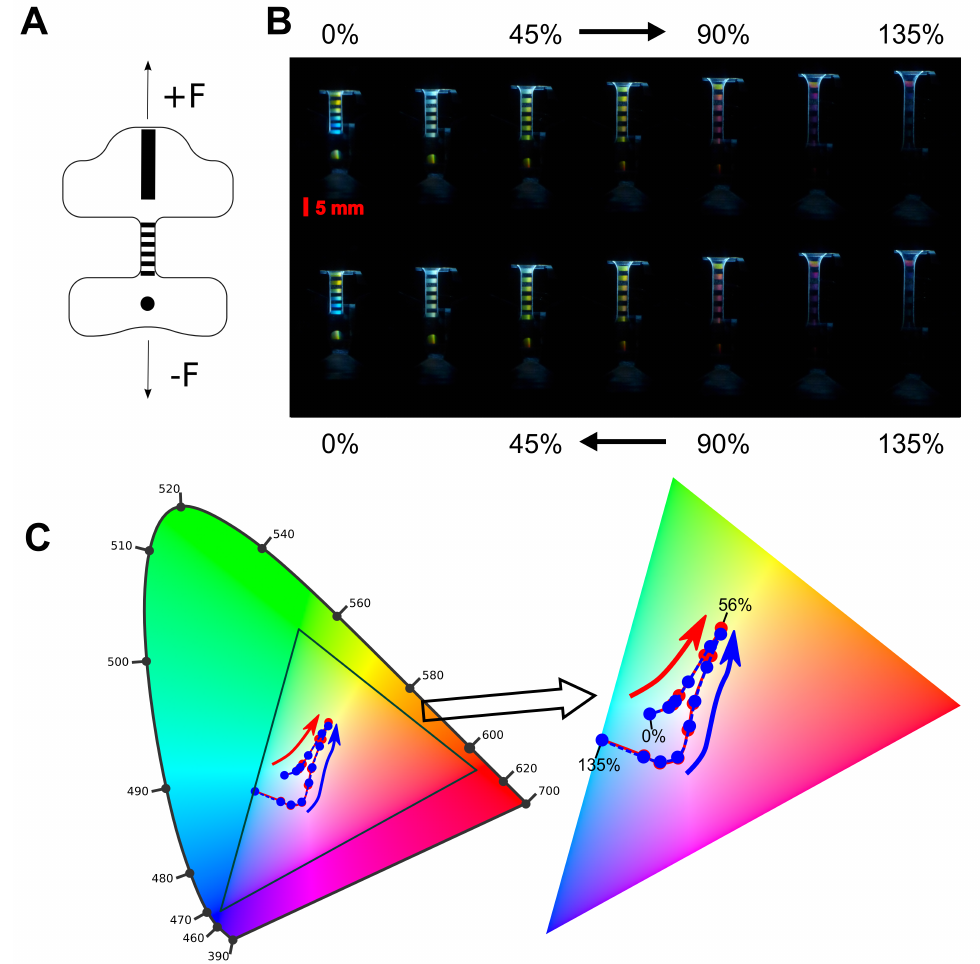
Figure 6. ( A ) Schematic diagram of the waveguide used for colourimetry measurements, the grating areas shown in black, a white light LED is positioned over the large grating at the top. Force is applied uniaxially. ( B ) Change in colour at the out-coupling gratings of a waveguide with applied strains between 0% and 135% using a white light input. ( C ) RGB analysis of the images in part ( B ). Extracted RGB values for each image are projected on a CIE xy chromaticity diagram, left, with an enlargement of the RGB region, right. Points are shown for stretching in red, and relaxing in blue. The position of the points while stretching and relaxing show high correlation due to the good repeatability of the method. True colour wavelengths are shown around the outside of the chromatic diagram, and the RGB colour limits are represented by the black triangle. Arrows show the direction of movement of the points with strain, red for stretching, blue for relaxing, and some strain values are labelled on the right.